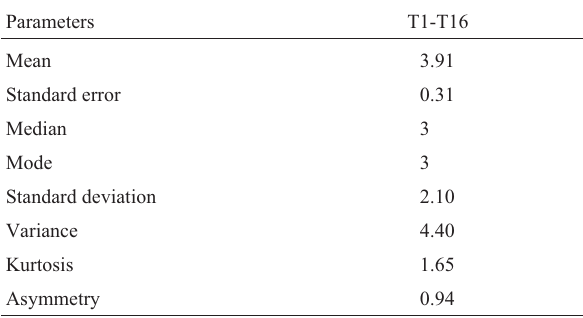
Figure 1 - Mean number of substitutions calculated from the alignment of terminal sequences (T1 to T16) of the experimental phylogeny in , re - corded for each 50 bp of the total length (2238 bp) of the 18S rRNA mole- cule. Table 2 - Descriptive analysis of the substitutions distribution along terminal sequences (T1 to T16) of the experimental phylogeny described by